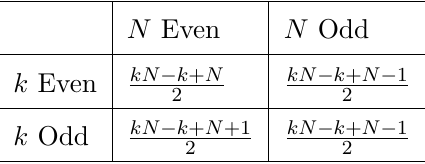
Table 2 . Dimensions of the Coulomb branch of the various